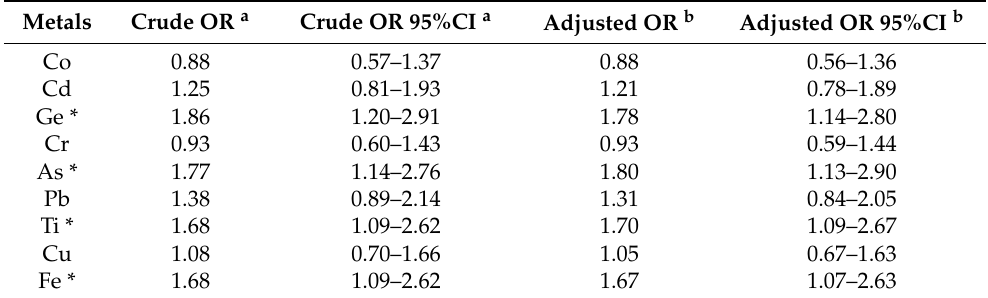
Table 3. Odds ratios (ORs) for the risk of higher heavy metal levels associated with passive